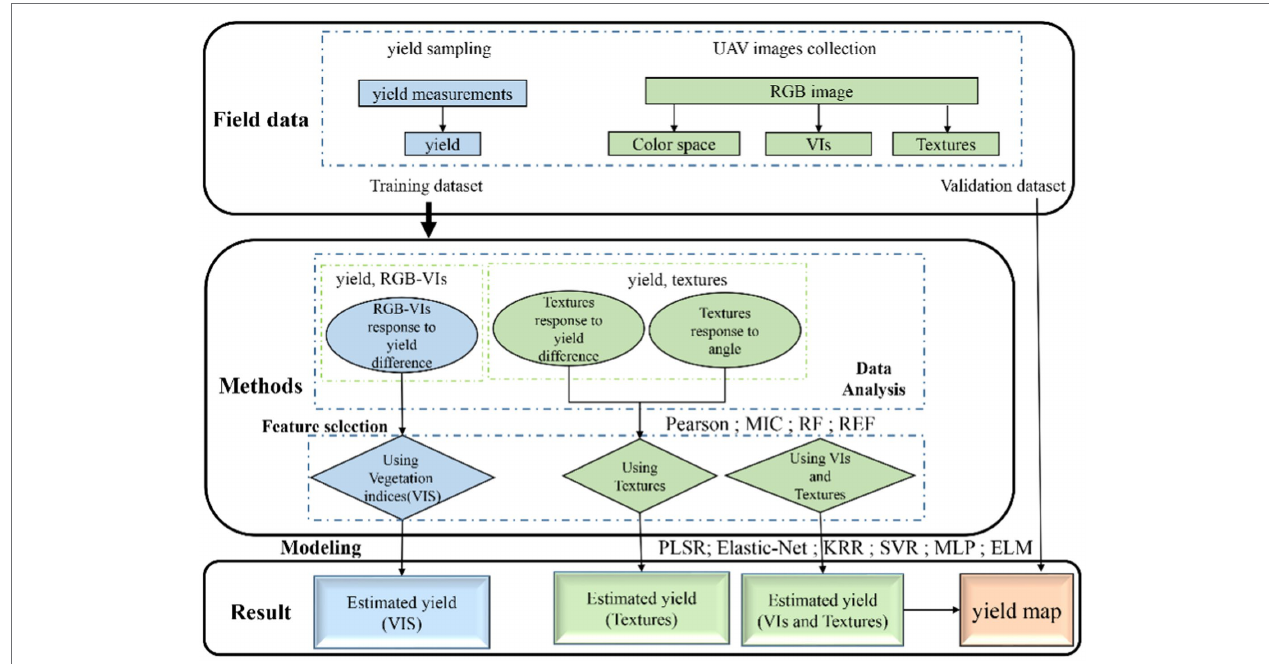
FIGURE 2 | This study involves the flowchart of data acquisition, data processing, and model